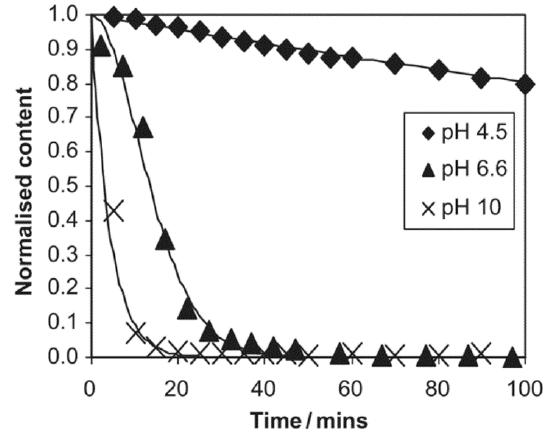
Figure 5. Consumption of GPS in different pH. Reprinted with permission from [26]. Copyright Elsevier,